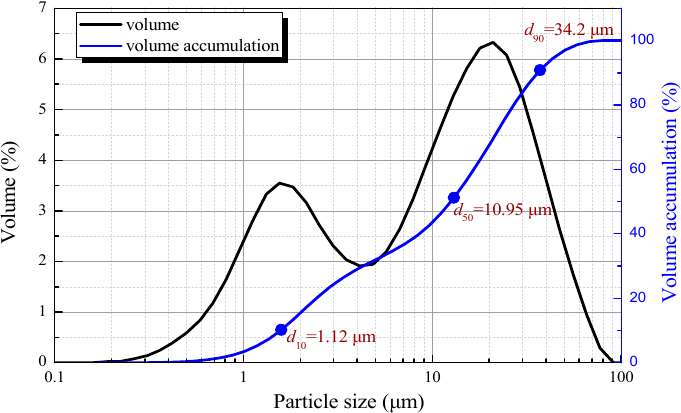
Figure 2. Laser particle size analysis of SZO.